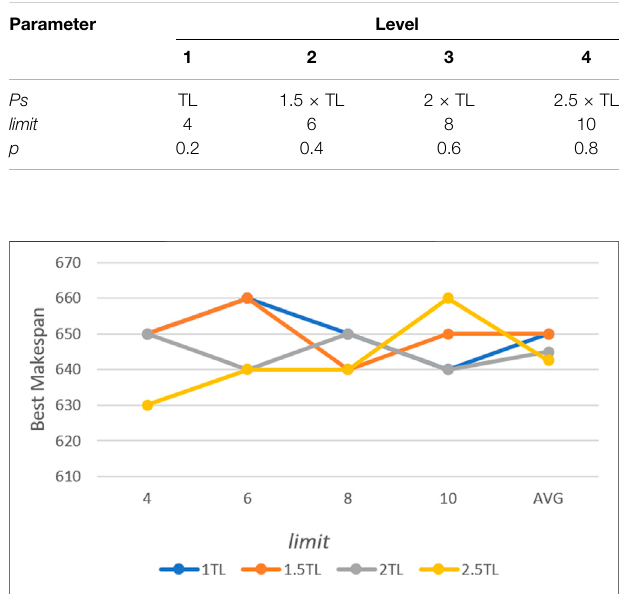
FIGURE 4 | Trend of best solution with Ps and limit .